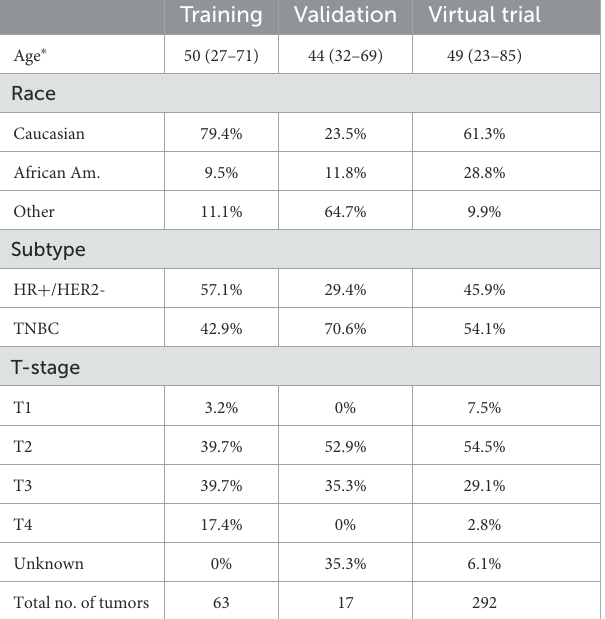
TABLE 1 Patient characteristics for data used in this